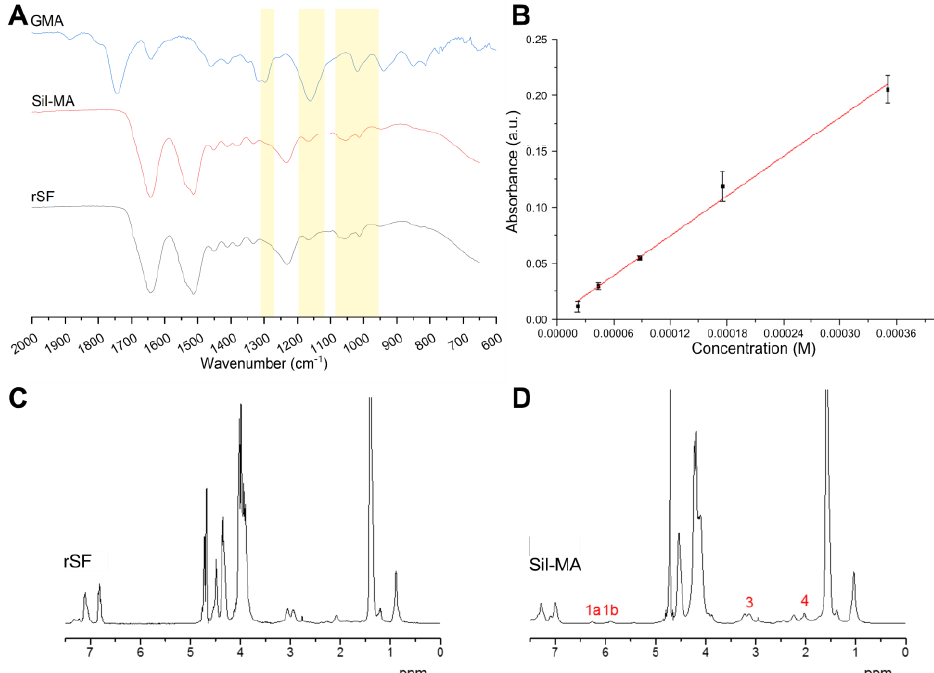
Figure 1. ( A ) FTIR-ATR spectra of regenerated silk fibroin (rSF) and methacrylated silk fibroin (Sil-MA); as reference, the spectrum of glycidyl methacrylate (GMA) was reported. Several modifications (indicated by yellow areas) of the Sil-MA spectra compared to the rSF spectra could be attributed to the presence of functional groups. ( B ) Calibration curve done using β alanine and the TNBS assay and used to determine the percentage of functional groups in Sil-MA. ( C , D ) NMR spectra of ( C ) rSF and ( D ) Sil-MA; the peaks present in Sil-MA but not in rSF are numbered and highlighted in red; they confirm the functionalization, except for peak 3, which is the lysine contribution.